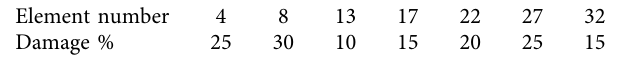
Table 1: Damage scenario of the 40-element beam. Element